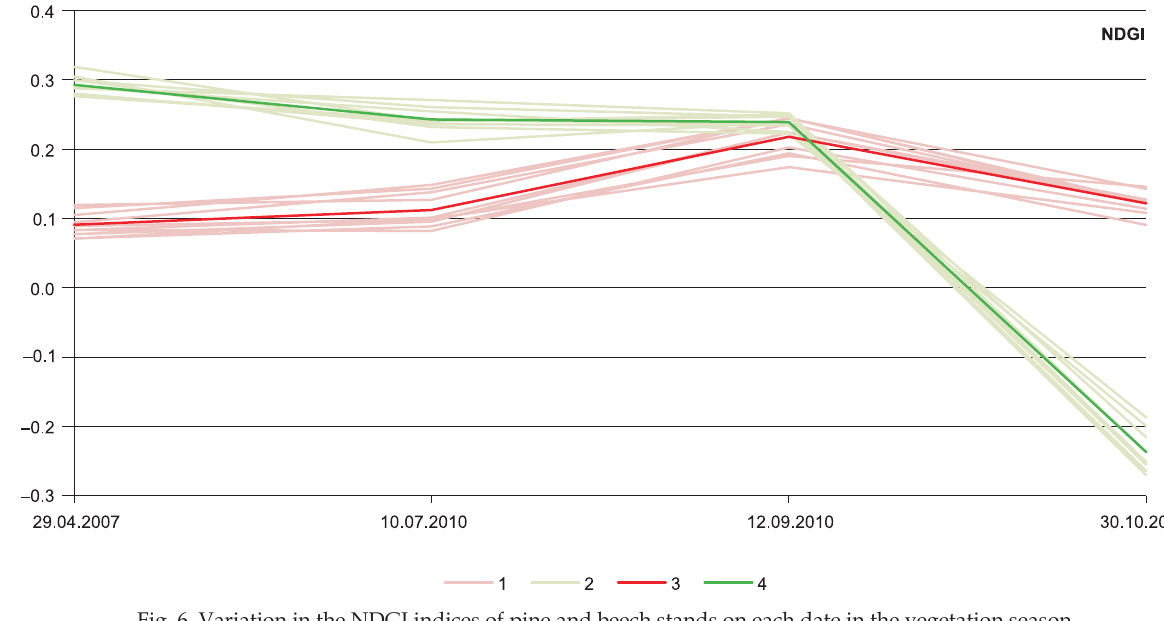
Fig. 6. Variation in the NDGI indices of pine and beech stands on each date in the vegetation season 1 – variation in indices for test areas of pine; 2 – variation in indices for test areas of beech; 3 – average index for pine stand; 4 – average index for beech